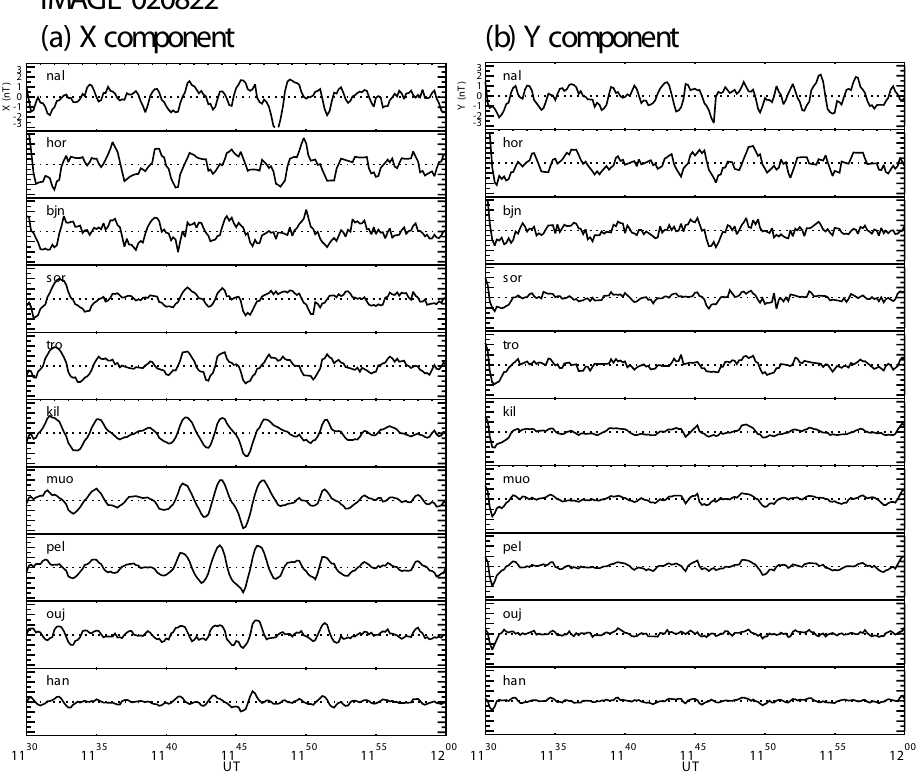
Fig. 8. ( a ) the X component and ( b ) the Y -component, IMAGE magnetometer data on 22 August 2002 for 11:30–12:00 UT, bandpass filtered between 300–20s.